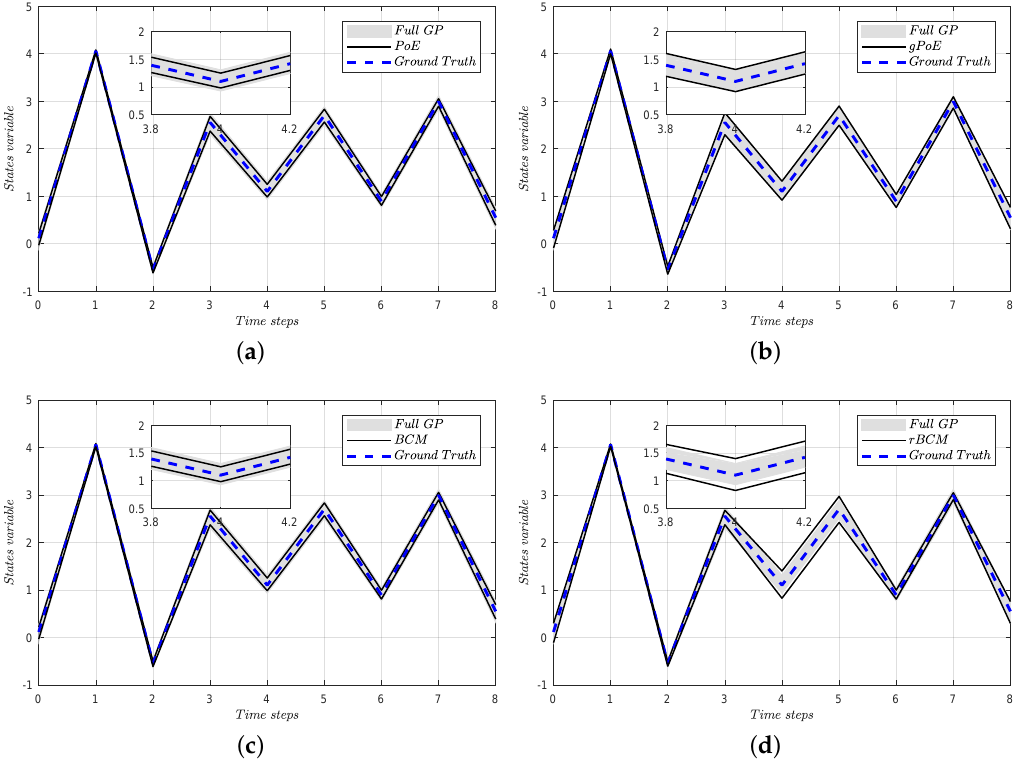
Figure 8. Comparison of four data fusion methods (product-of-GP-experts (PoE), generalized PoE (gPoE), Bayesian committee machine (BCM), robust Bayesian committee machine (rBCM)) for the distributed forward model. In each subfigure, the confidence interval of the comparison algorithm is filled between two black lines. Additionally, the full GP to be approximated is shown in the gray shaded area, representing 95% of the confidence interval, and the ground truth is given in blue dashed line. We apply NLL (negative log-likelihood) to evaluate the fusion performance presented in Table 3.